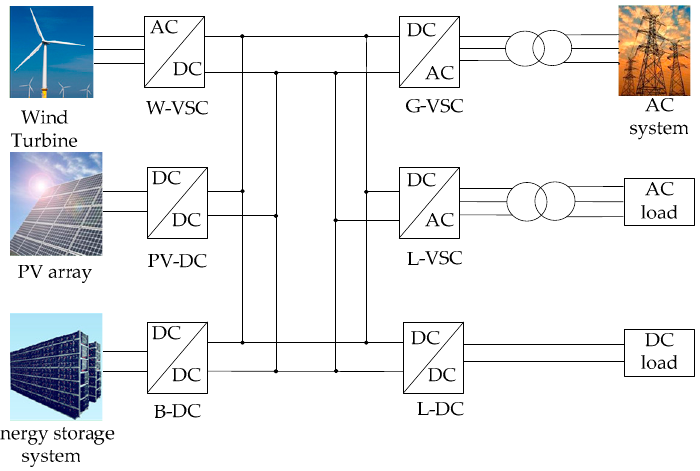
Figure 1. Typical structure of DC distribution systems.